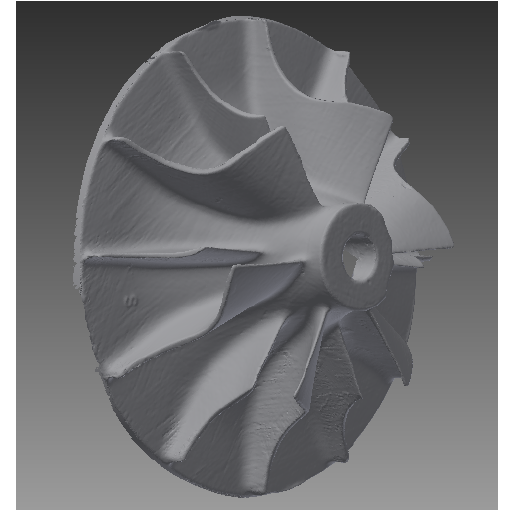
Figure 3: 3D scan of the compressor